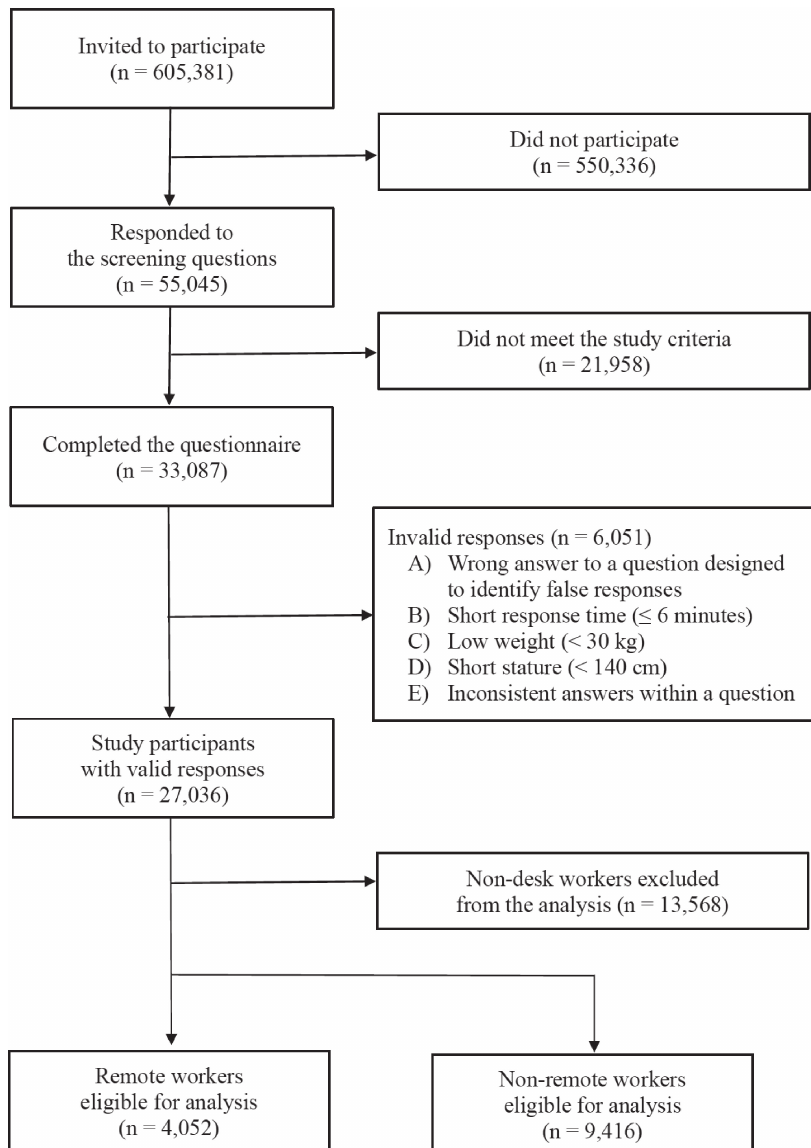
Fig. 1 Flow chart of eligible participants in the current